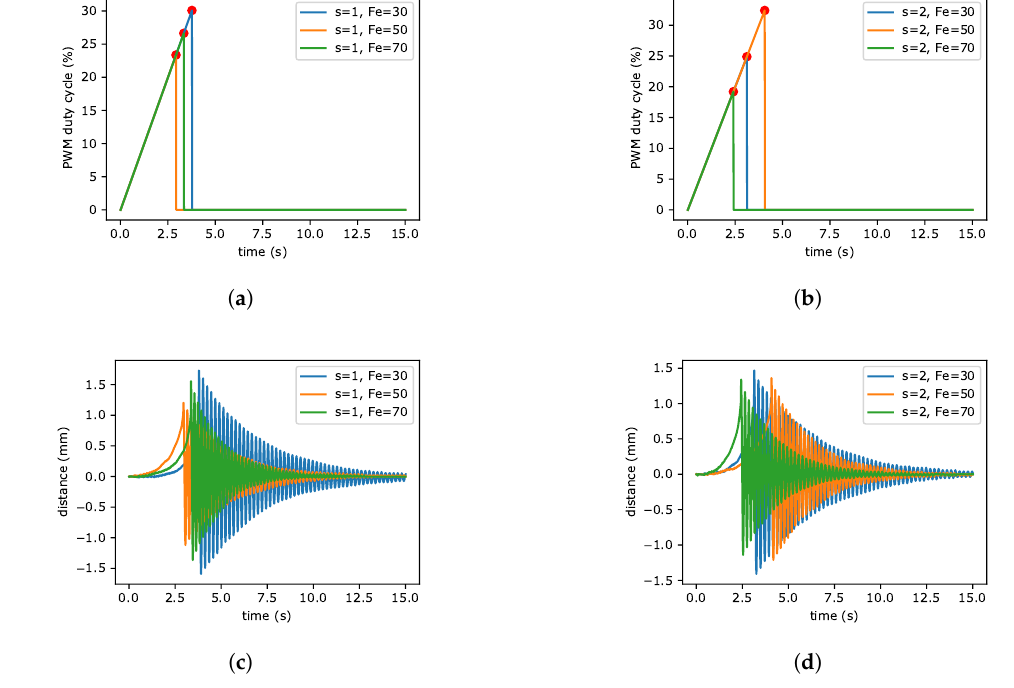
Figure 5. The free vibrations of MRE beam. The duty cycle of PWM and distance response for sample 1 ( a , c ). The duty cycle of PWM and distance response for sample 2 ( b , d ).